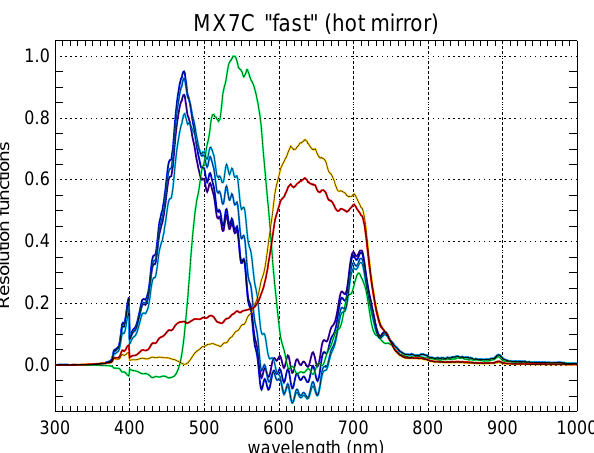
Figure 12. Resolution/window functions ( A ) for ICX429AKL in “fast” mode with smoothing µ = 1 and retrieved wavelengths of 391.4 (dark blue), 427.8 (blue), 470.9 (light blue), 486.1 (cyan), 557.7 (green), 630.0 (orange), and 777.7nm (red).